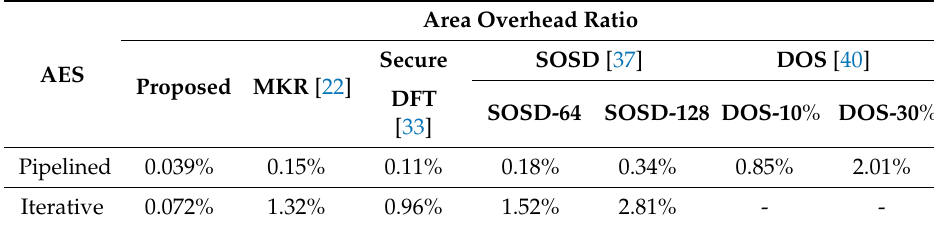
Table 4. Area overhead comparison of different secure